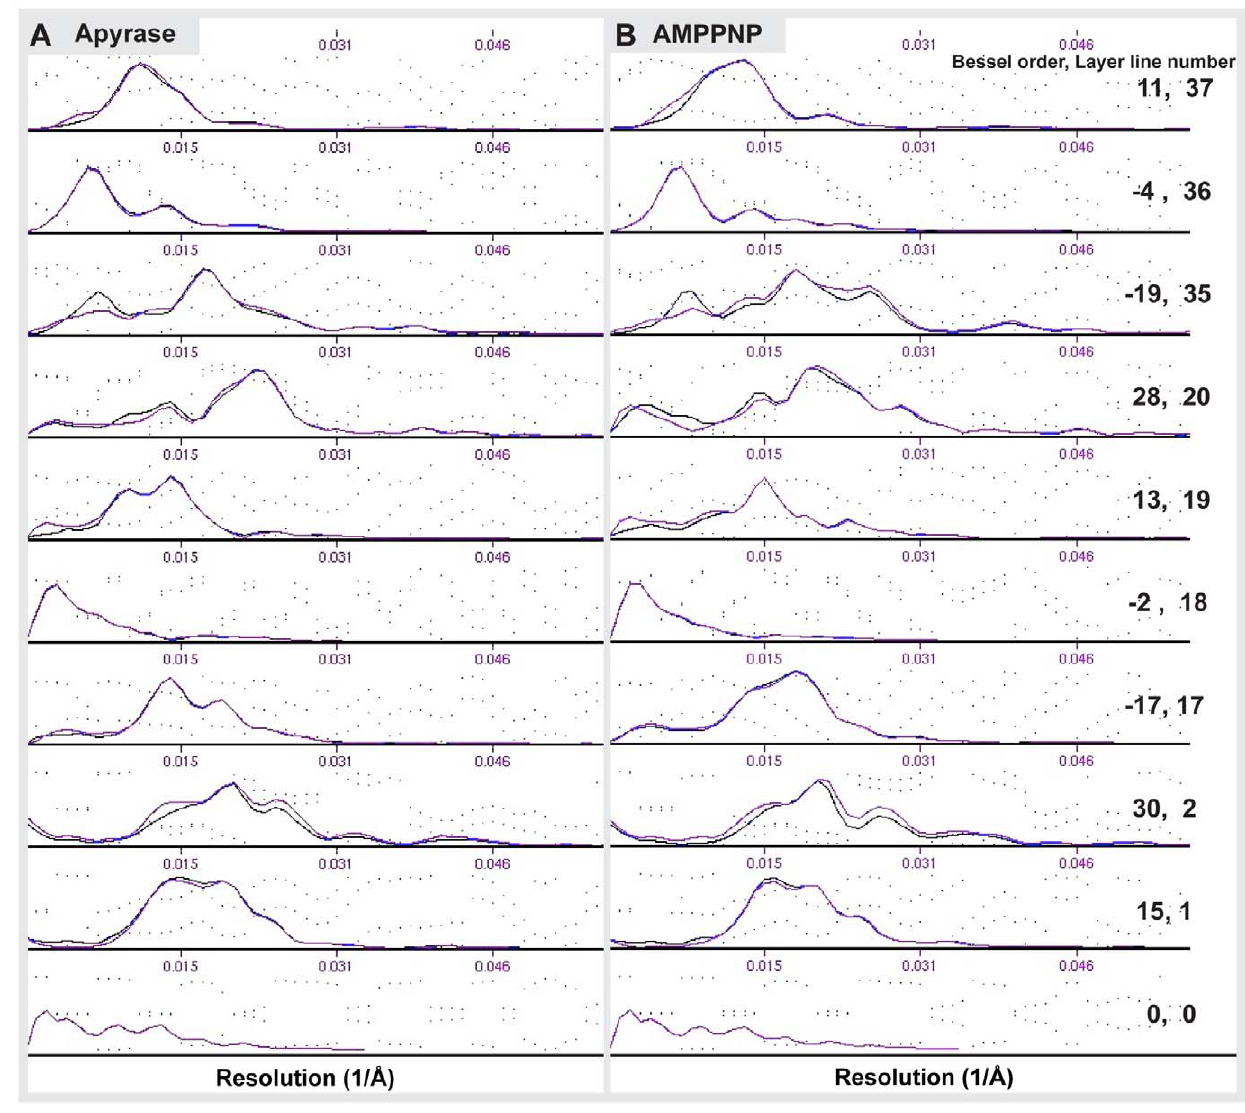
Figure 2. The MT binding configuration of Kar3Vik1 in different nucleotide states. Fourier-filtered images (top row) and corresponding Fourier transforms (bottom row) of Kar3Vik1 trapped on the MT at key points during its nucleotide hydrolysis cycle. ( A ) In the presence of Kar3Vik1- ADP, MTs appear predominantly undecorated. ( B ) In the nucleotide-free state, achieved by incubating Kar3Vik1 with apyrase, MTs are fully decorated and clearly show Kar3Vik1 binding to the MT with only one of its globular domains, with the second domain detached and extending away from the MT. Similarly, Kar3Vik1-AMPPNP, trapped in the ATP state ( C ), and Kar3Vik1-ADP-AlF4-, mimicking the ADP + Pi state ( D ) bind to the MT in a one-head- down, one-head-up configuration. Dotted red circles highlight the difference in the binding configurations of the nucleotide-free and AMPPNP states. The ADP- AlF4- state appears similar to the AMPPNP state configuration. The structural differences and similarities between the nucleotide states are shown in more detail in Fig. 3. In these images, it is not possible to know whether it is Kar3 or Vik1 in contact with the MT though this is addressed in Fig. 4. strongly resemble that of the Kar3Vik1-AMPPNP MT-bound state (Fig. 3C). The resemblance of the maps of the AMPPNP and ADP-AlF4- binding states suggests that Kar3Vik1 does not use the hydrolysis of ATP to ‘reset’ the position of its stalk to a pre- powerstroke position (the position seen in the ADP-bound [6] and nucleotide-free states (Fig. 3A)). Rather, ATP hydrolysis may convert the motor to a weak MT-binding state and the stalk returns to its original position only after Kar3Vik1 detaches from the MT.